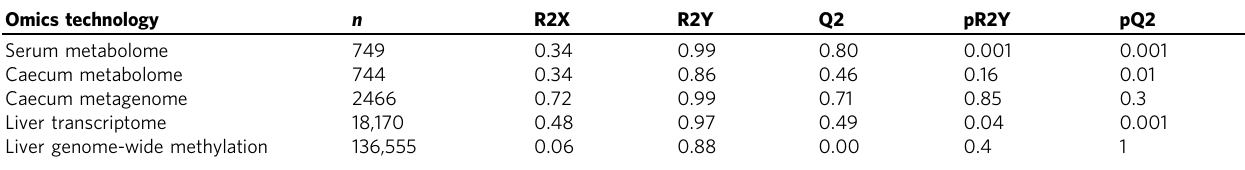
OPLS-DA models were performed for each set of omics data. We show estimates of the total explained variation (R2X), variations between the different groups (R2Y) and the average prediction capability (Q2). We assessed the signi fi cance of our classi fi cation using permutation tests. The number of variables investigated ( n ) is also shown. New estimates of R2Y and Q2 values were calculated from this 1000 times permuted dataset ( p values pR2Y and pQ2 for permuted R2Y and Q2,